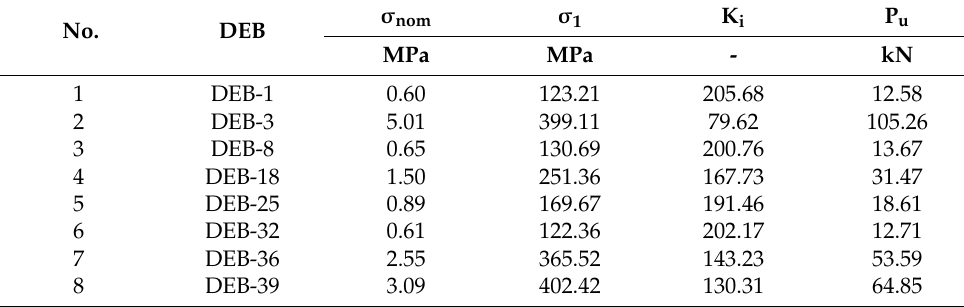
Table 6. The stresses and SCF of RC-DEBs based on RSG-C